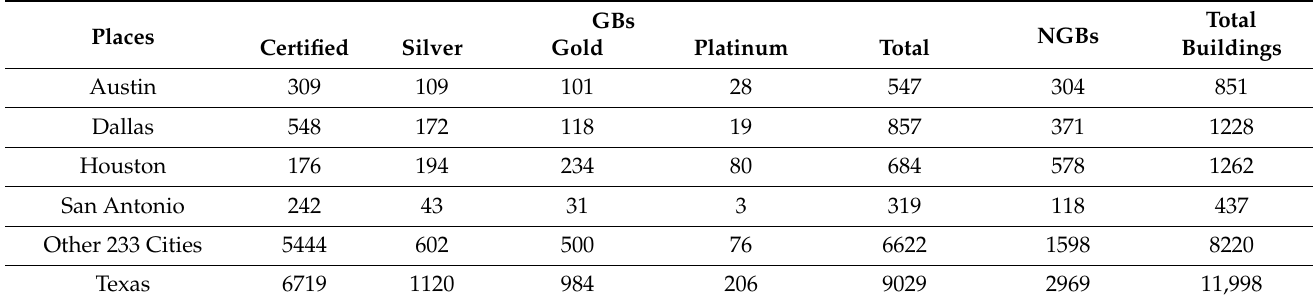
Table 1. Number of data